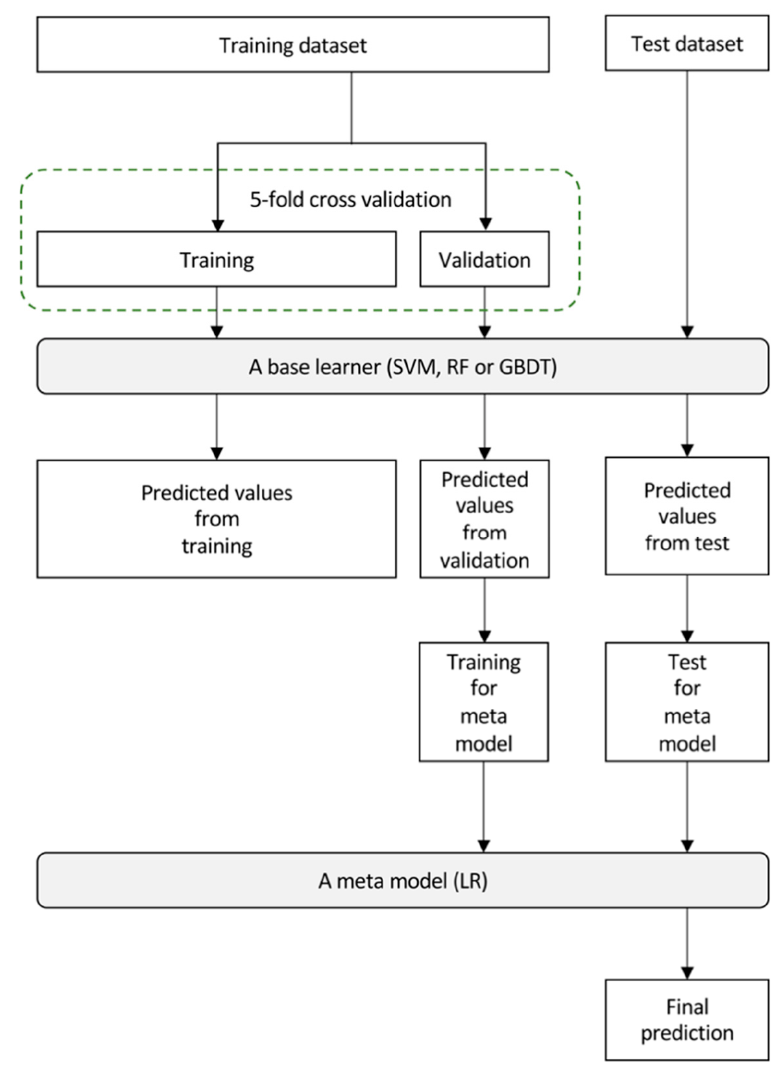
Figure 3. A workflow for building of an imaging biopsy model based on stacking ensemble learning for this study.